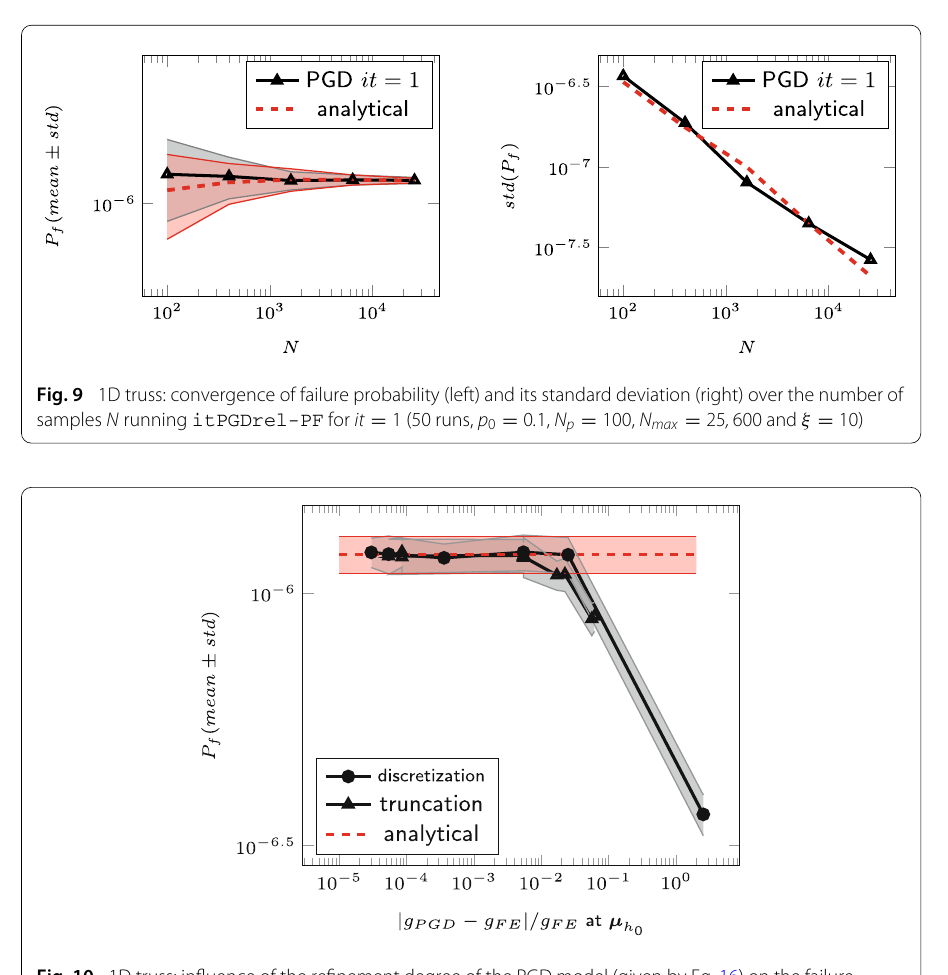
Fig. 10 1D truss: influence of the refinement degree of the PGD model (given by Eq. 16) on the failure probability P f based on 50 runs of itPGDrel-PF with varying PGD solutions regarding mesh discretization from the initial iteration it = 0 and p 0 = 0 . 1, N p = 100 and N = 1600 are and number of modes ( μ h 0